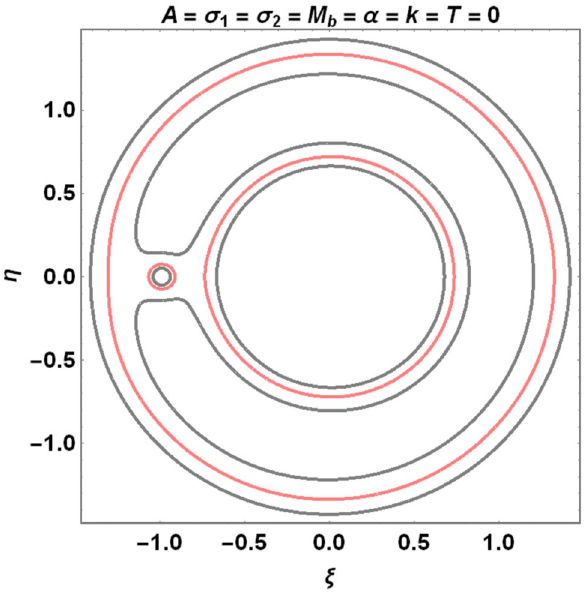
Figure 2. Zero velocity curves for µ = 0.01215, e = 0.0549, a = 1.000453, A = σ 1 = σ 2 = α = k = M b = T = 0 showing the boundary relations.